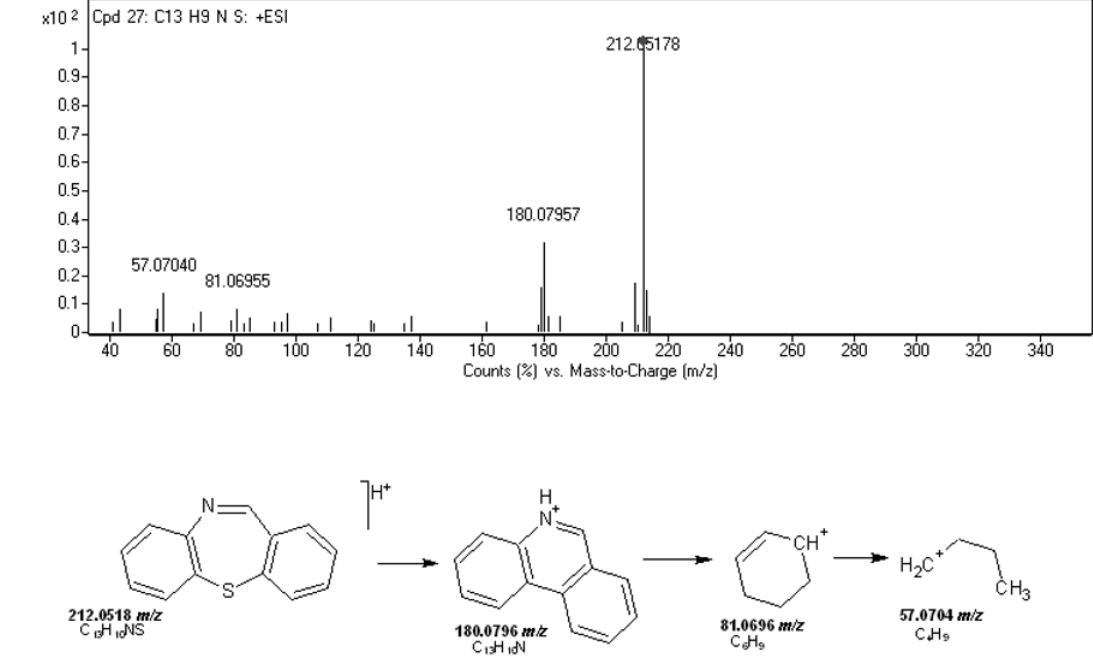
Figure 5. Q-TOF MS/MS spectrum and fragmentation pathway of photodegradation product D3 ( t